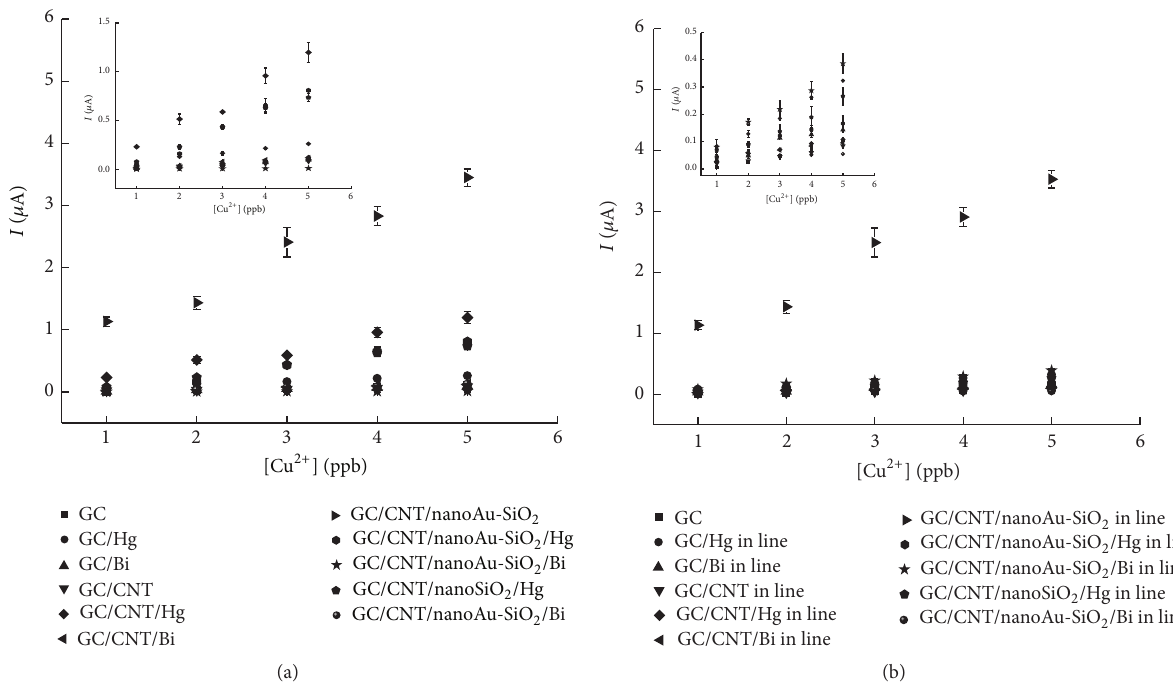
Figure 3: Graph comparing analytical calibration curves for analysis of Cu 2+ using the glassy carbon electrode and its modifications with nanomaterials and metals. (a) Method 1. (b) Method 2.